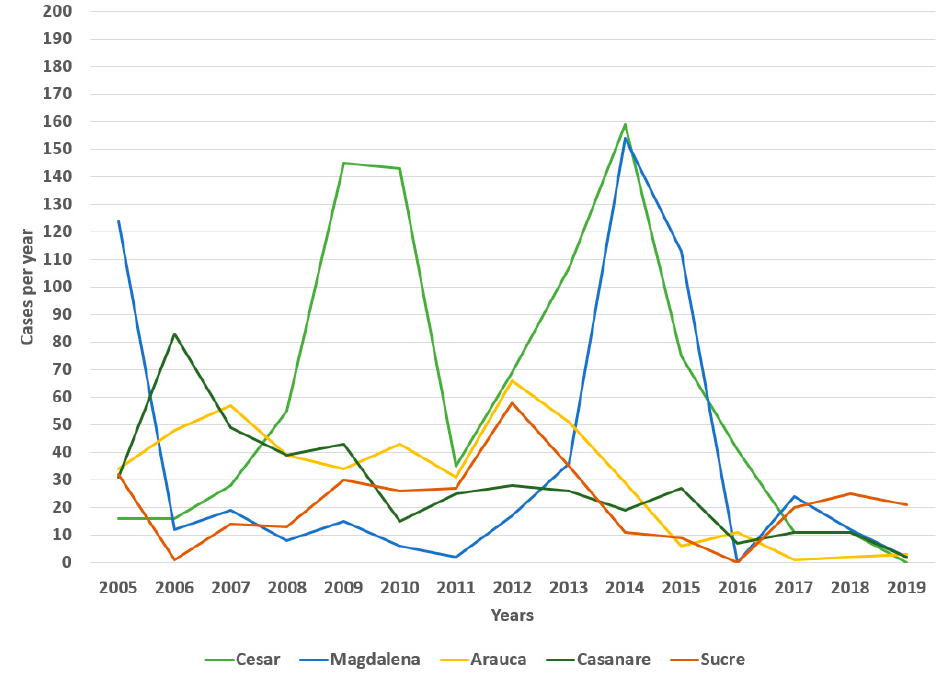
Figure 5. Departments with the highest bovine rabies cases, Colombia, 2005–2019.